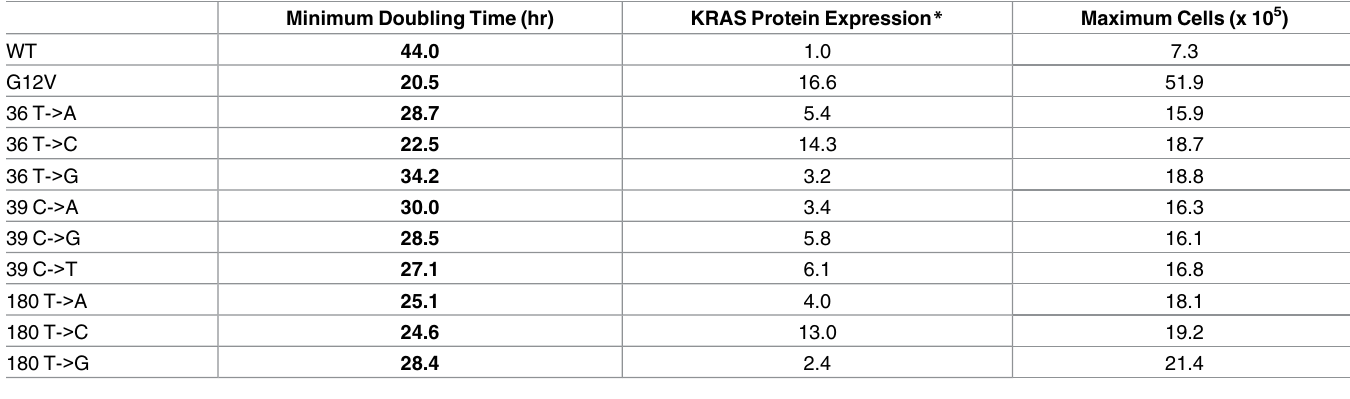
Table 2. Single synonymous mutations changed KRAS expression, doubling times, and cell